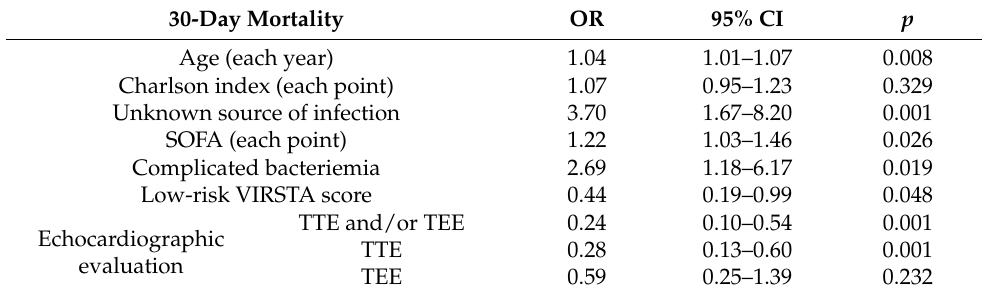
Table 5. Multivariate logistic regression model of mortality and echocardiographic